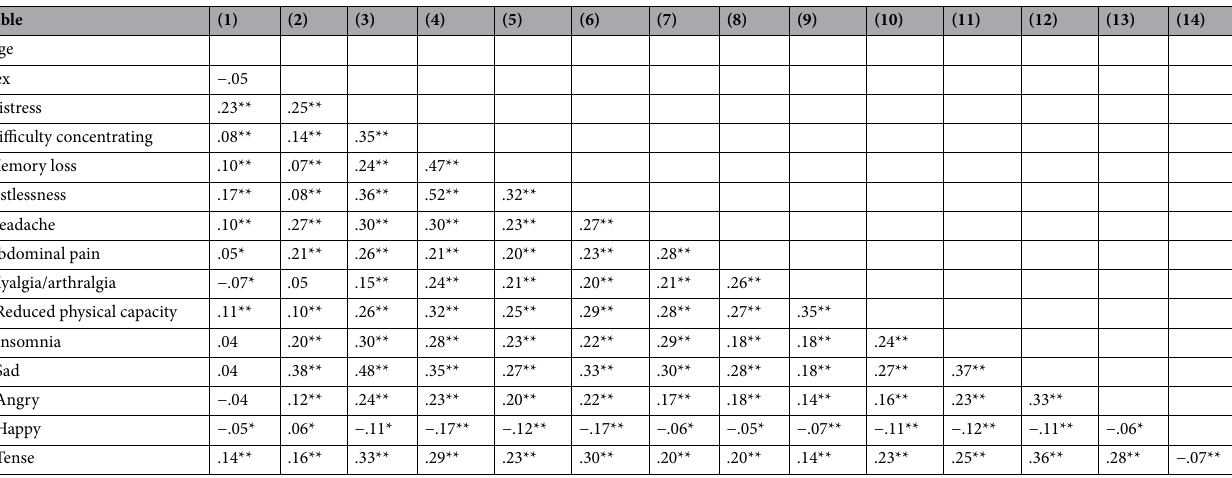
Table 3. Spearman-Rho bivariate correlations between age, sex, and the reported neurocognitive, pain and mood symptoms ( n = 1504, * p < .05, ** p < .01 (one-tailed test)).